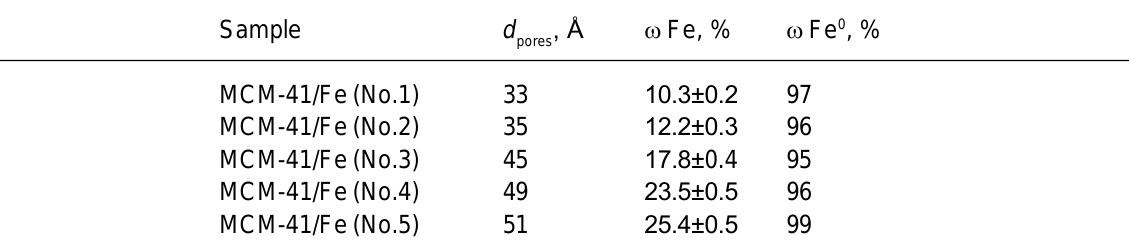
Table 2. Pore size and composition of the samples